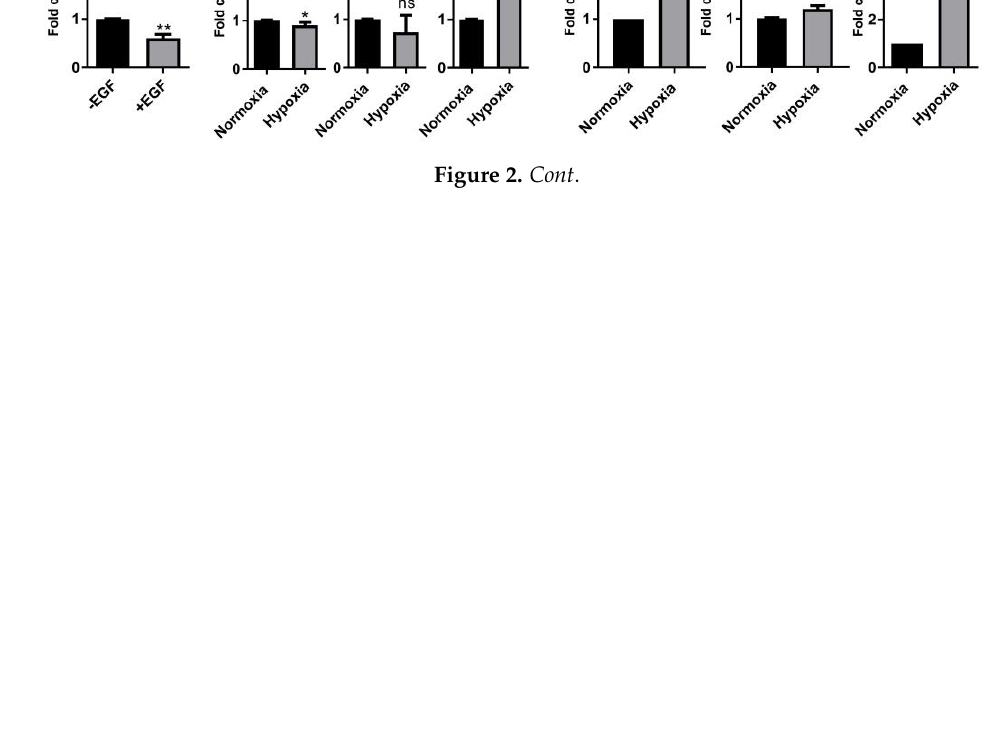
Figure 2. Hypoxia induces ORAI3 expression. ( A ) ORAI3 expression after EGF treatment (24 h, 50 ng/mL) treatment in MDA-MB-468 cells ( B ) mRNA expression of ORAI1 , ORAI2 and ORAI3 after hypoxia (24 h, 1% O 2 ) in MDA-MB-468 breast cancer cells compared to cells maintained in normoxia. ( C ) Induction of ORAI3 expression after hypoxia (24 h) in HCC1569, ( D ) MDA-MB-231 and ( E ) PMC42LA breast cancer cells. ( F ) Assessment of ORAI3 expression in breast (MCF7), colon (HT29) and prostate (Du145) after exposure of cells to normoxia (time-point 0 h) and different times of severe hypoxia (0% O 2 for 1, 2, 4, 8, 12, 16 and 24 h, respectively) extracted from the publicly available data [47] using the R2 genomics analysis platform. ( G ) confirmation of siRNA-mediated Orai3 silencing and ( H ) FLIPR traces (left) and quantification (right) of the mean [Ca 2+ ] CYT levels during store-operated Ca 2+ entry with ORAI3 silencing (siORAI3) and non-targeting siRNA control (siNT) in MDA-MB-468 cells exposed to 48 h hypoxia. ( I ) Spontaneous Ca 2+ transients in MDA-MB-468 cells expressing GCaMP6m following ORAI3 silencing (siORAI3) and 48 h exposure to hypoxia. Ca 2+ transients in 20 individual cells unbiasedly selected from a single well following silencing of non-targeted siRNA control ( I ), or ORAI3 ( J ). Highlighted lines represent examples of cells exhibiting spontaneous Ca 2+ activity. ( K ) Percentage of cells exhibiting spontaneous Ca 2+ activity. ( L ) Stratification of cells by